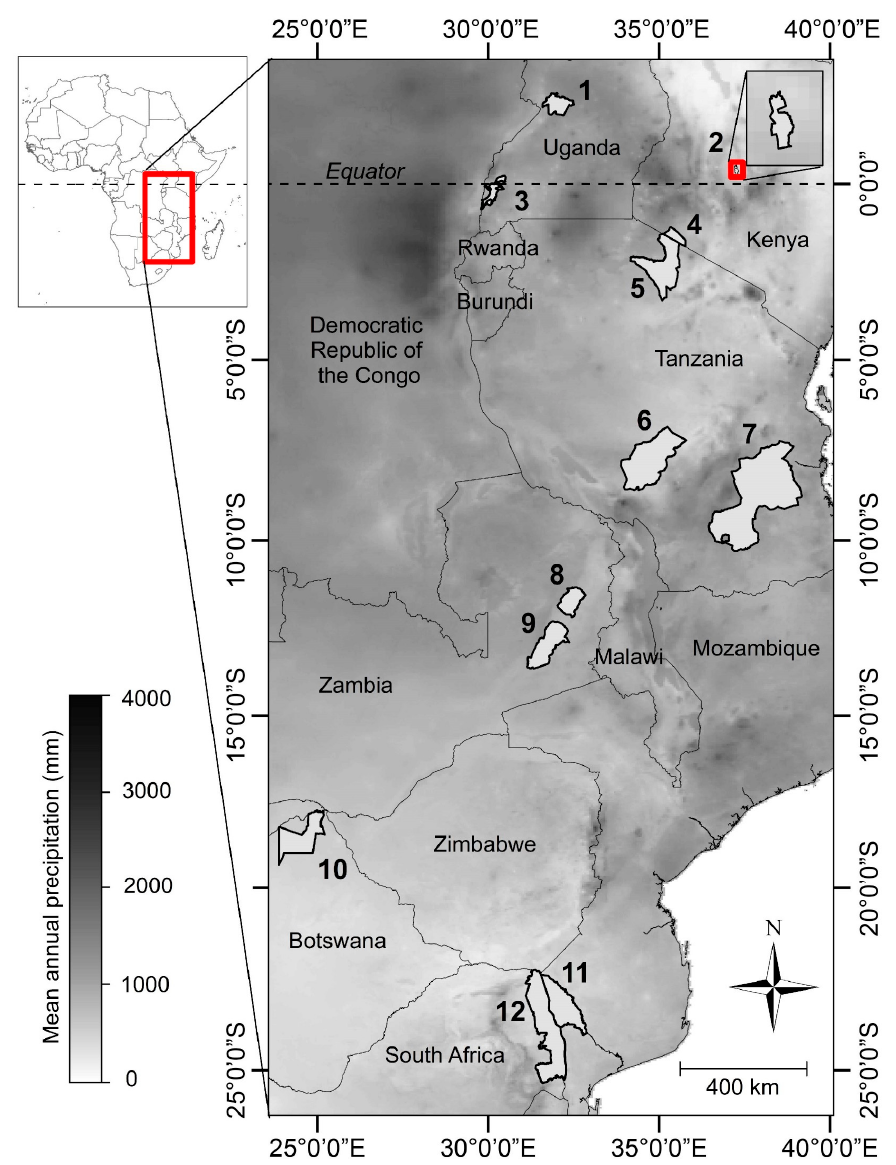
Figure 1. The twelve protected areas used in this study. Red boxes denote inset map borders. The background represents the mean annual precipitation from 1988–2017 [63]. See Table 1 for corresponding protected area (PA) names and attributes. Mpala Research Center (2) is ~11 km at its widest point (no scale in